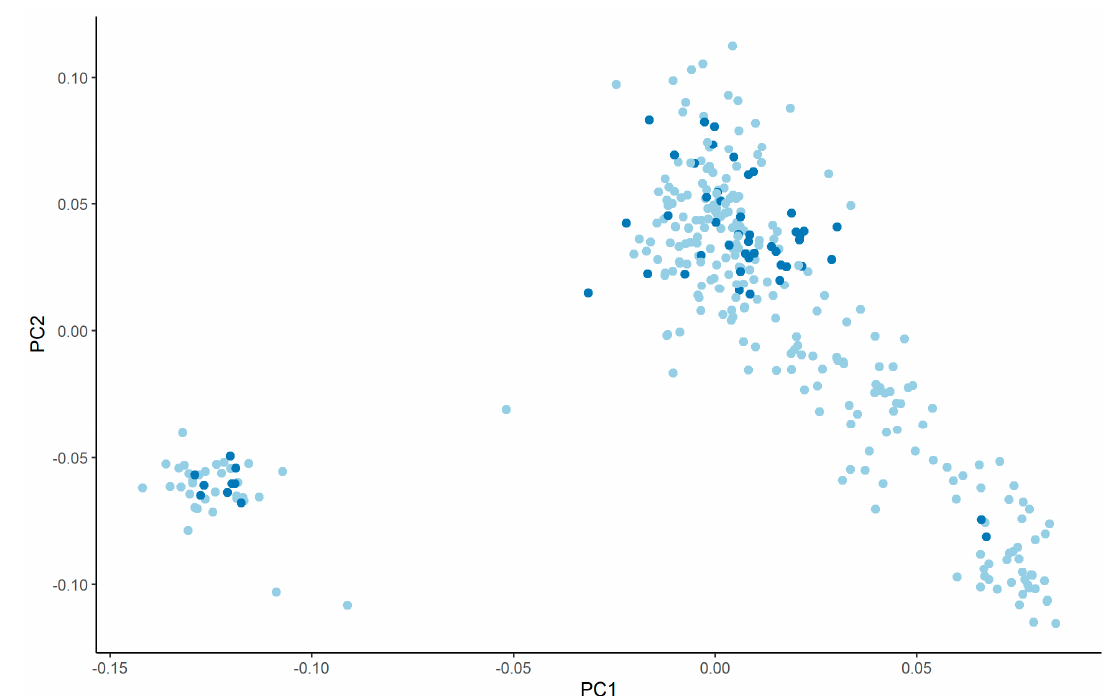
Figure 4. First (PC1) and second (PC2) principal components of the genomic relationship matrix with different colors for farms (Farm 1 = light, Farm 2 = dark).